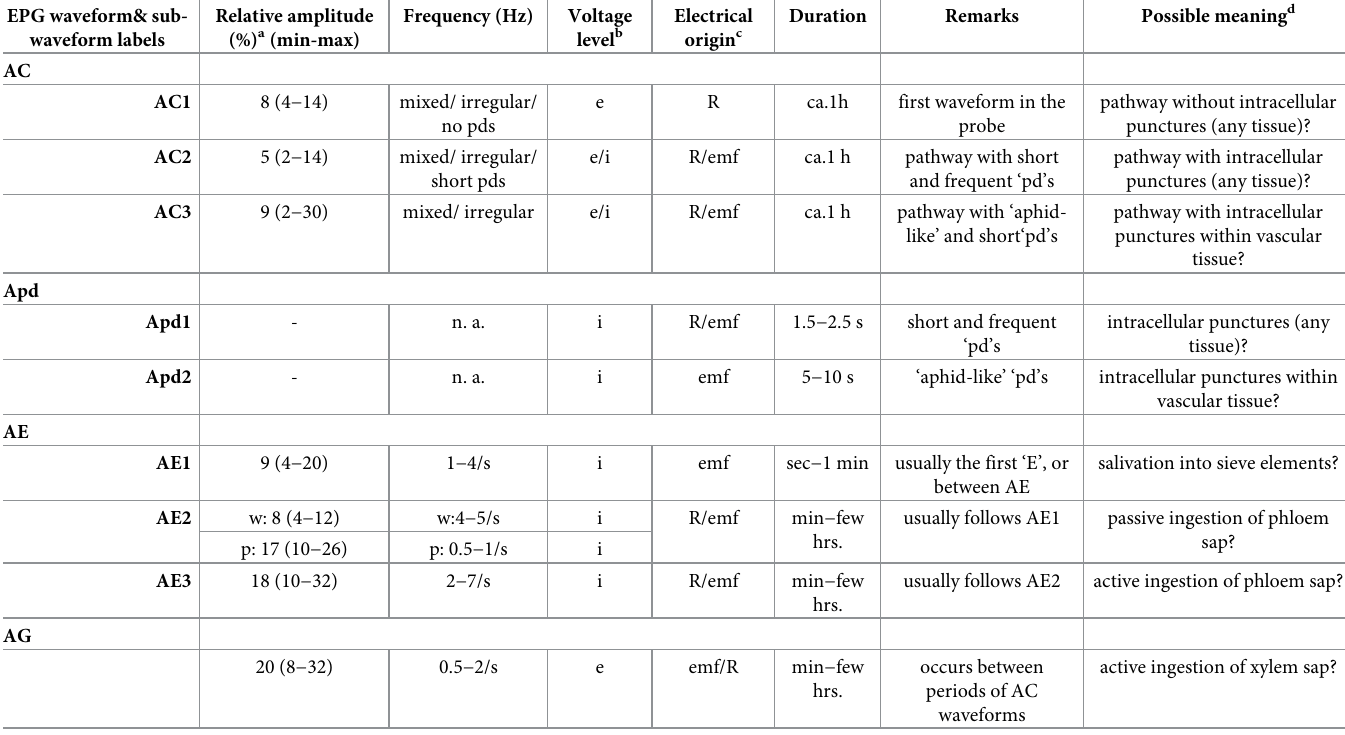
Table 1. Characteristics and suggested meaning of EPG-recorded waveforms generated by Adelges laricis during probing on Larix decidua . EPG waveform& sub- waveform